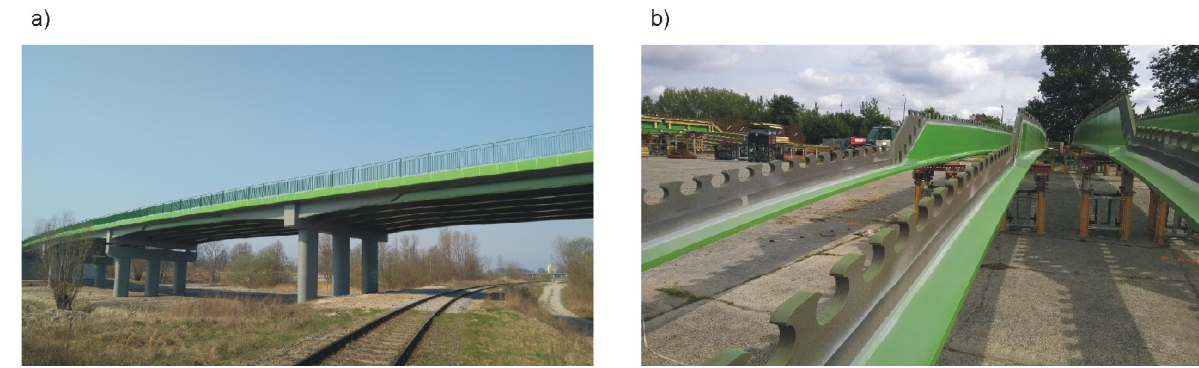
Figure 1: Steel–concrete hybrid beams of innovative composite bridge constructed using composite dowels in Poland, 2016.